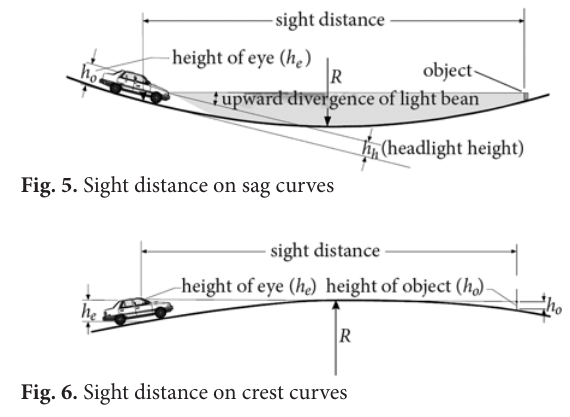
Table 2. Minimum sight distances, m, in symmetric sag arcs characterised by variable curvature for selected radii R , m Minimum curvature radius Curve Gradient in vertical curve central point (relative to initial gradient) Circular arc